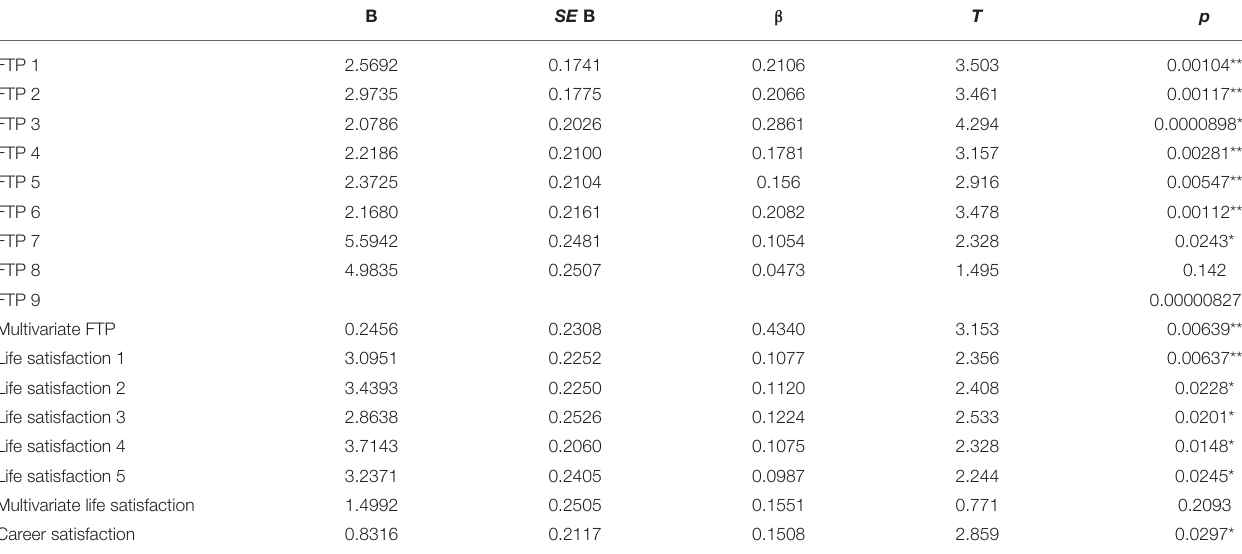
TABLE 5 | Logistic regression between the question “how close is your relationship with your family members?” and measures of future time perspective (FTP), life satisfaction, and career satisfaction.